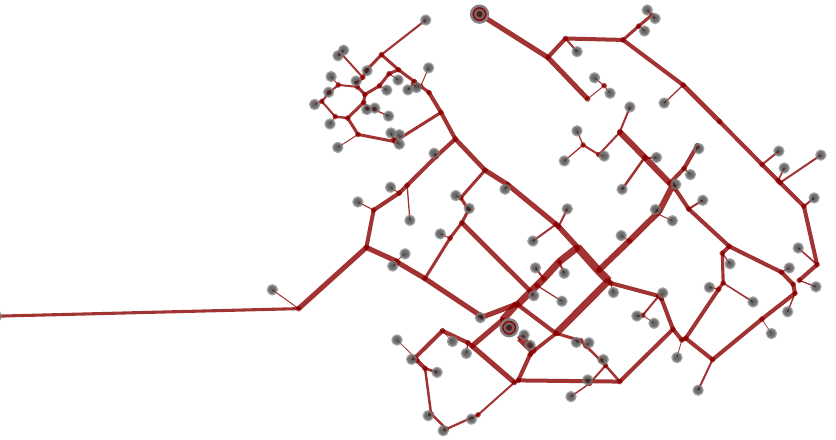
Figure 7. The resulting district heating systems of FZJ separation scenario